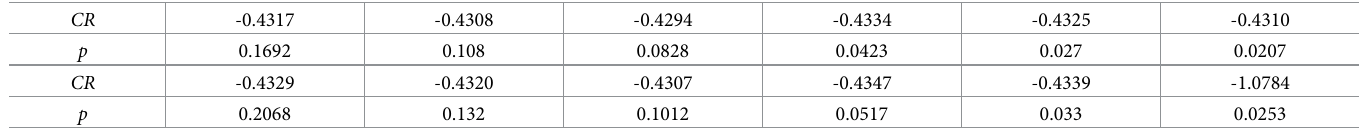
Table 4. Probability distribution of consistency index CR